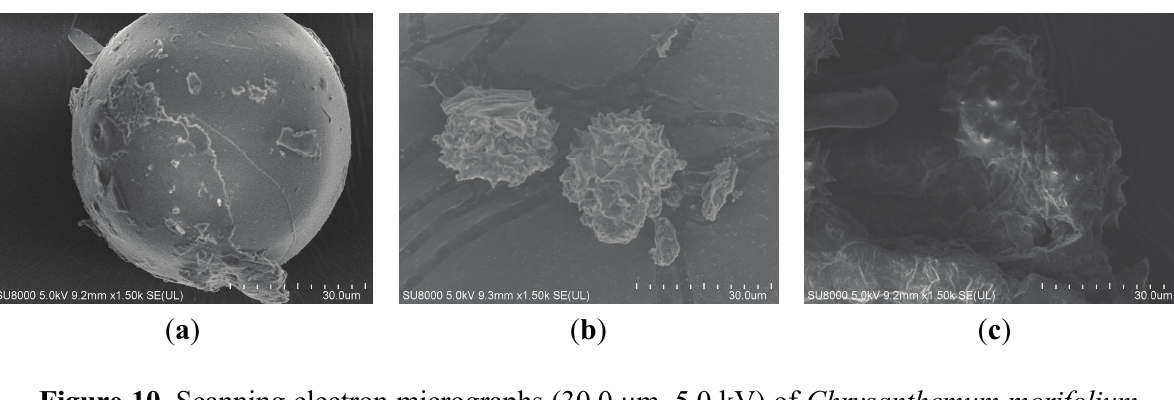
Figure 10. Scanning electron micrographs (30.0 μ m, 5.0 kV) of Chrysanthemum morifolium Ramat flowers. ( a ) Untreated sample; ( b ) After heating extraction by ethanol 2 h; ( c ) After